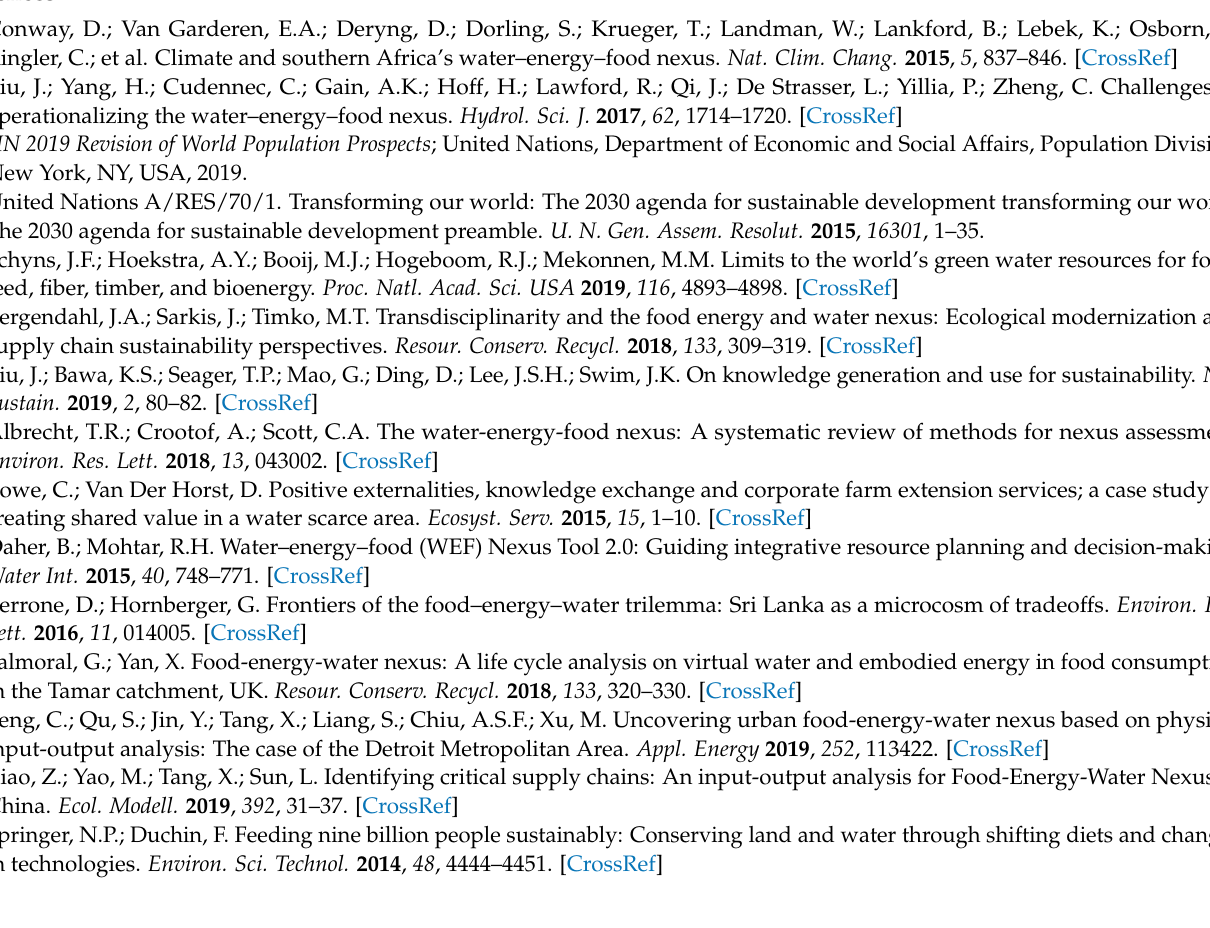
carbon prices, Figure S2: SSPs situation in terms of challenges for adaptation and mitigation, Figure S3: Overview of basic SSPs, the energy sector elements of the narratives and the Shared Climate Policy Assumptions (SPAs), Figure S4: Evolution of the output by technology of vehicle production (million USD) in SSP3 “inequality”. Table S1. Model Parameters and Variables (m regions, n sectors, technologies. Minimum water quality type required, Table S3: World Trade Model Regions,